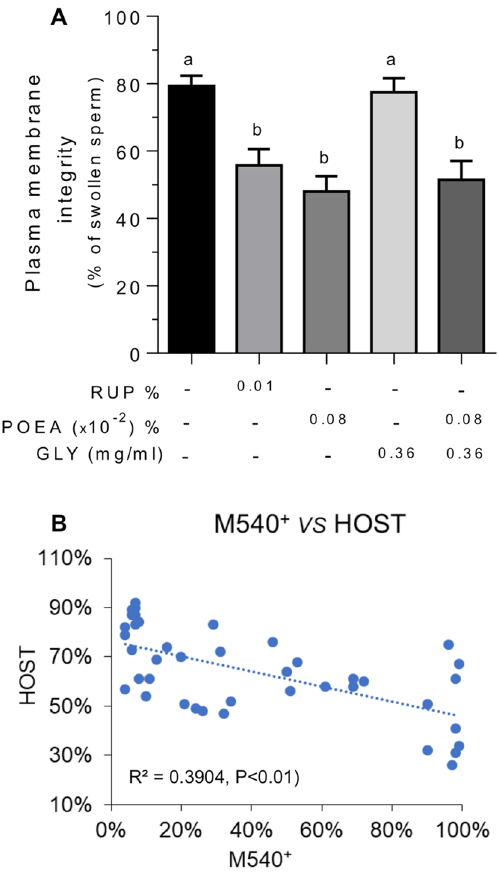
Figure 3. Effects of Roundup Ultra Plus (RUP), glyphosate (GLY) and surfactant polyoxyethylene tallow amine (POEA) in functional integrity of human sperm plasma membrane (HOS test). ( A ) Spermatozoa were incubated in BWW for 1 h at 37 °C, 5% CO 2 , in the absence or presence of indicated concentrations of RUP, POEA, GLY or POEA in combination with GLY. This experiment was performed 7 times (n = 7) and the results were expressed as the mean of the percentage of swollen spermatozoa ± standard error of the mean (SEM). Columns with different letters are statistically different from each other, so that for P < 0.05. ( B ) Negative correlation between the lipid disorganization (M540-positive and Yo-Pro-1-negative spermatozoa) and the functional integrity (HOS test) of the human sperm plasma membrane. Values were result of 7 independent experiments (n = 35). The resultant Pearson coefficient is statistically significant for the negative correlation, (r = − 0.625, P <